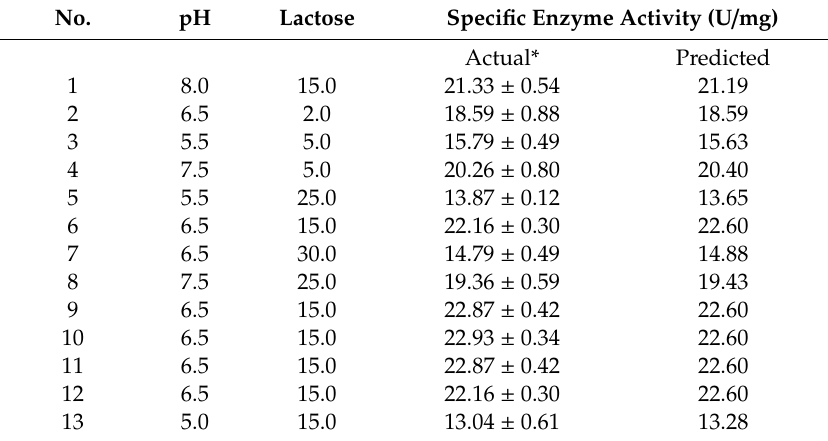
mean standard deviation of three independent experiments. ±